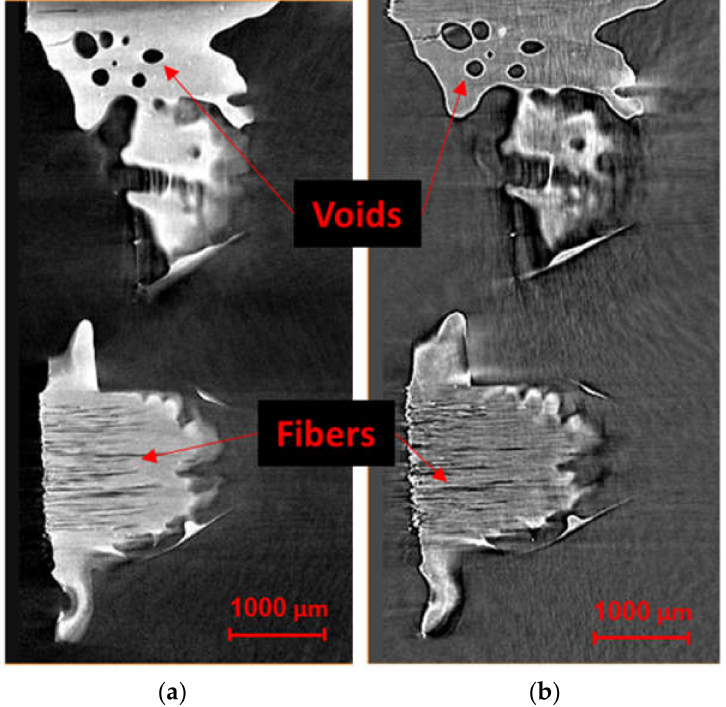
Figure 10. Top-view of fiber directions and air bubbles in ( a ) absorption contrast and ( b ) propagation phase-contrast